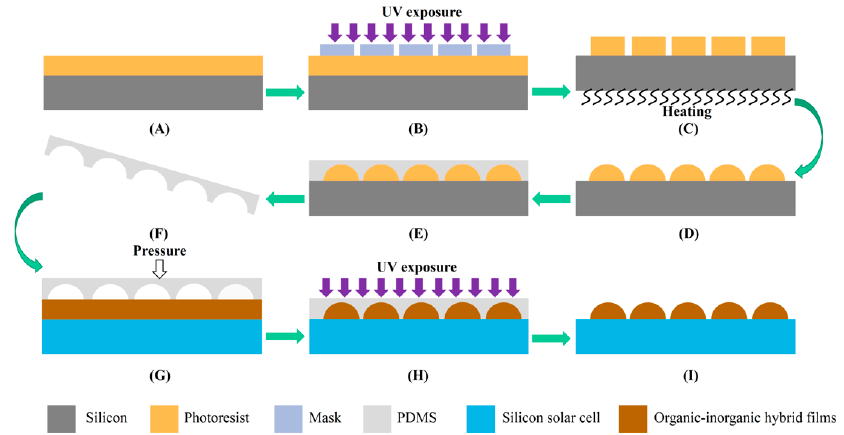
Figure 2. Experimental flowchart of MLAs built in bare silicon solar cells. ( A ) Spin-coating of photoresist thin films on a silicon substrate; ( B ) the photoresist films are placed under the irradiation of ultraviolet light with a mask; ( C ) thermal reflow process; ( D ) photoresist MLAs template; ( E ) slowly dumping the PDMS precursor over the MLAs template; ( F ) gently removing the PDMS to obtain the MLAs soft mold; ( G ) the PDMS mold is tightly attached to the hybrid films’ surface deposited on silicon solar cells; ( H ) exposing the sample to UV light for solidification; and ( I ) silicon solar cells are obtained with organic–inorganic hybrid film MLAs.